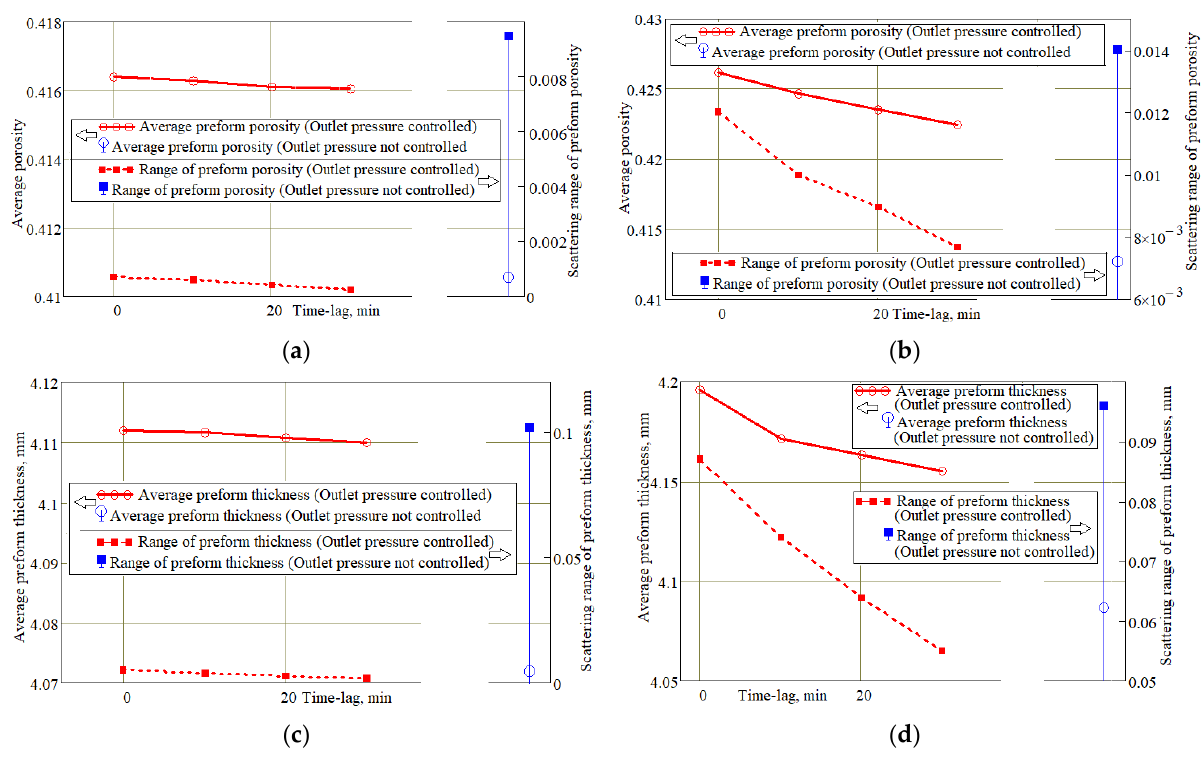
Figure 14. Comparative diagrams of the final indicators of porosity ( a , b ) and preform thickness ( c , d ) provided by the first ( a , c ) and second ( b , d ) scenarios of post-infusion exposure under various pressure control strategies.